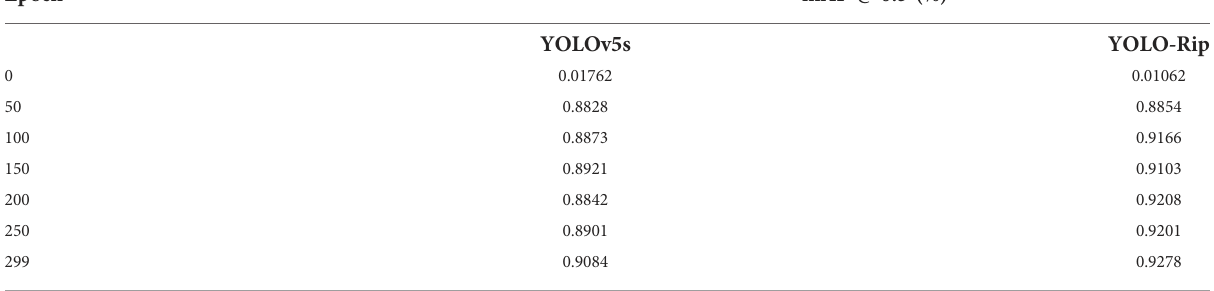
TABLE 6 Comparison of mAP values between YOLOv5s and YOLO-Rip training datasets.